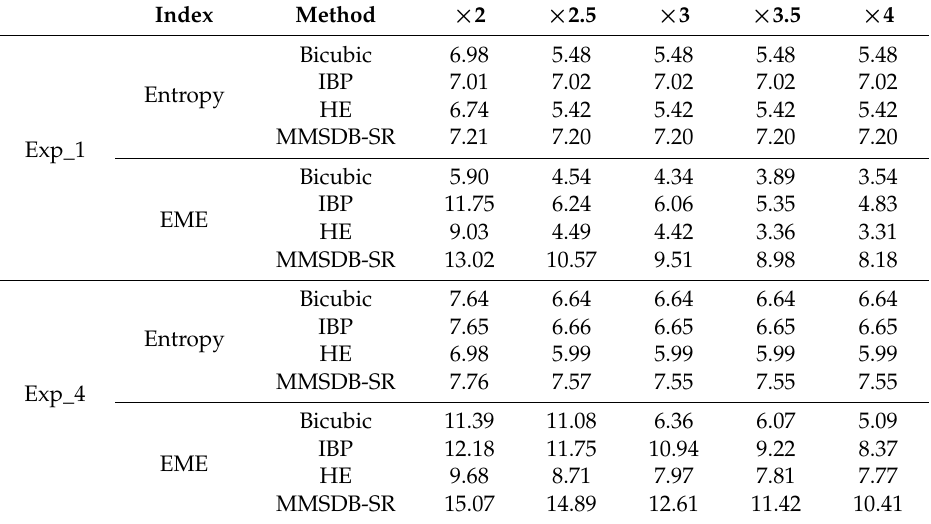
Table 8. Objective evaluation indexes of different-scale reconstruction